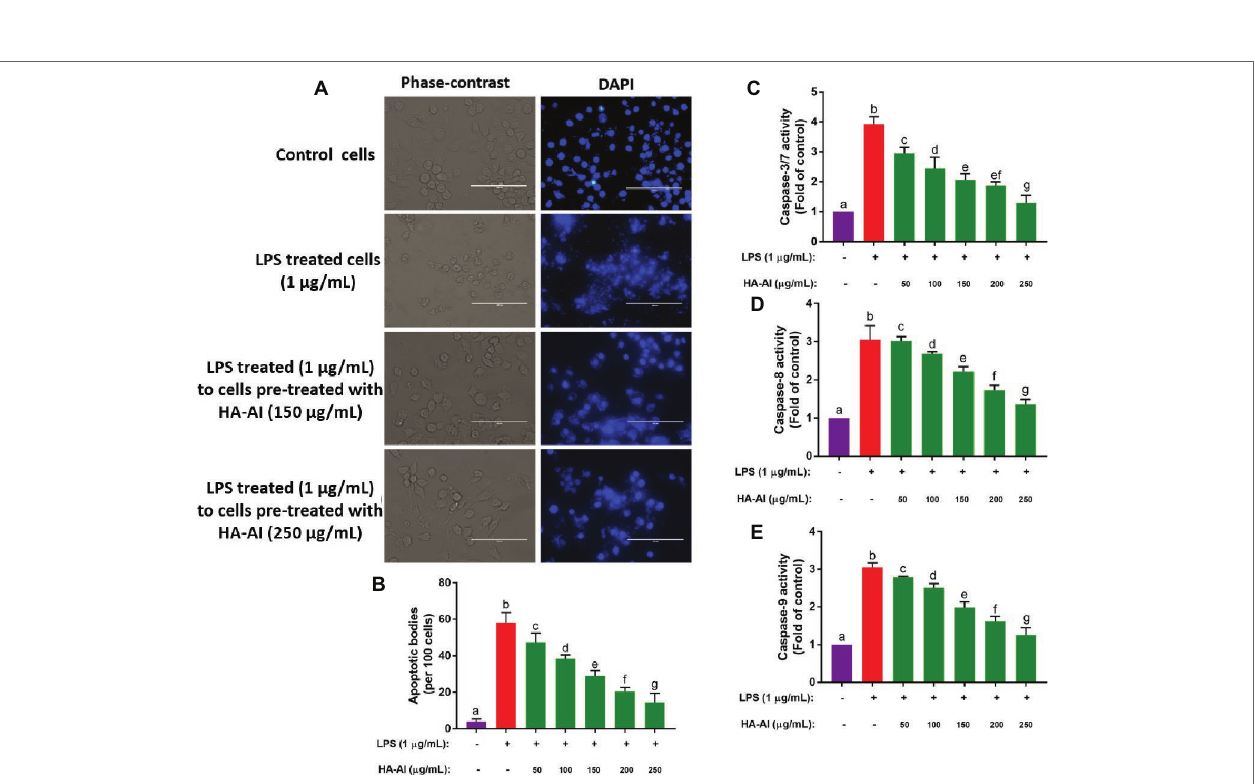
FIGURE 10 | Assessment of protective efficacy of hydroxyapatite– A. indica (HA-AI) composite on LPS-induced nuclear damage and apoptosis in RAW 264.7 cells. (A) Phase contrast and fluorescent microscopic images depicting the protective efficacy of HA-AI composite on LPS-induced nuclear damage by DAPI staining. (B) Dose-dependent protective efficacy of HA-AI composite on LPS-induced apoptosis by DAPI staining. (C–E) Dose-dependent restoring efficacy of HA-AI composite on LPS-induced depletion of caspases (3/7, 8, and 9). The experiments were performed individually in six replicates and achieved results were stated as mean ± standard deviation. The data were statistically evaluated by one-way ANOVA following Tukey’s post hoc multiple comparison test. The statistical variance among the experimental groups was measured as significant at p < 0.05. The columns with different alphabets were significant within the respective